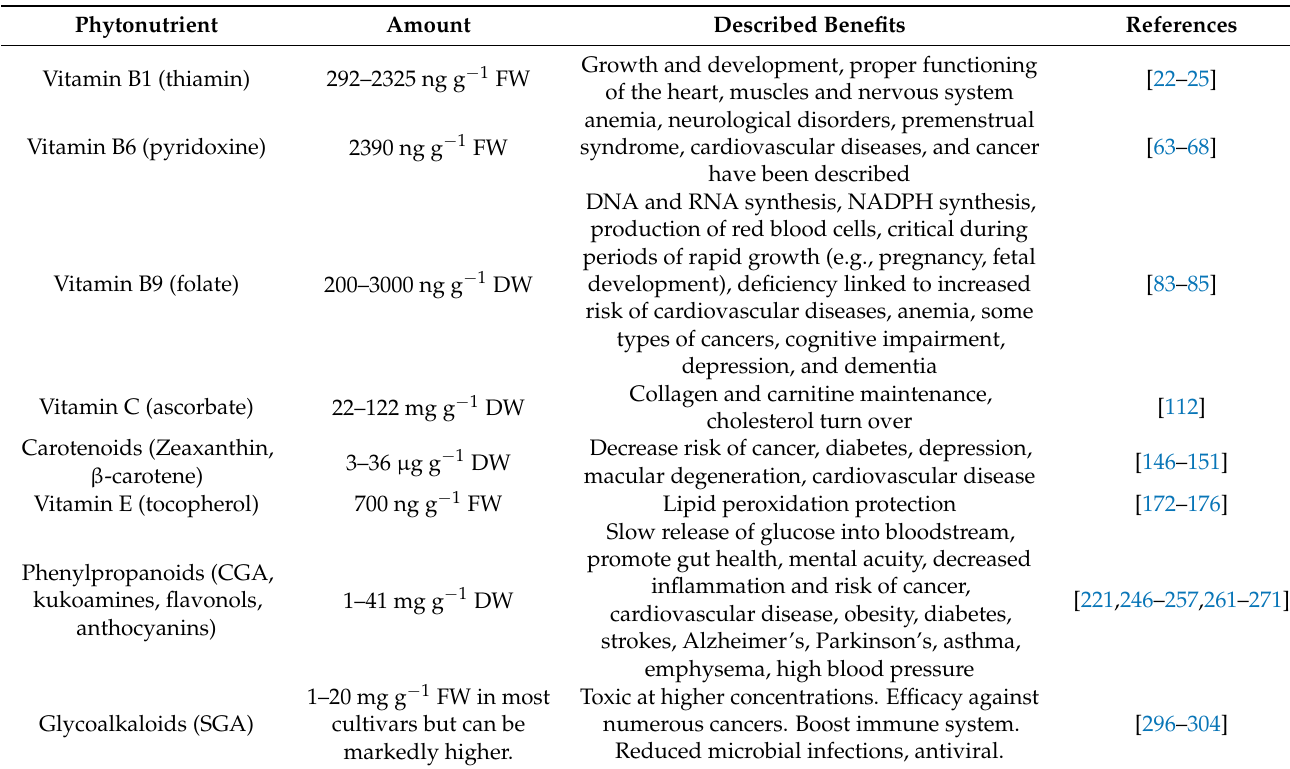
Table 1. Potato phytonutrients discussed in this review article, range of amounts found in tubers, and health benefits for